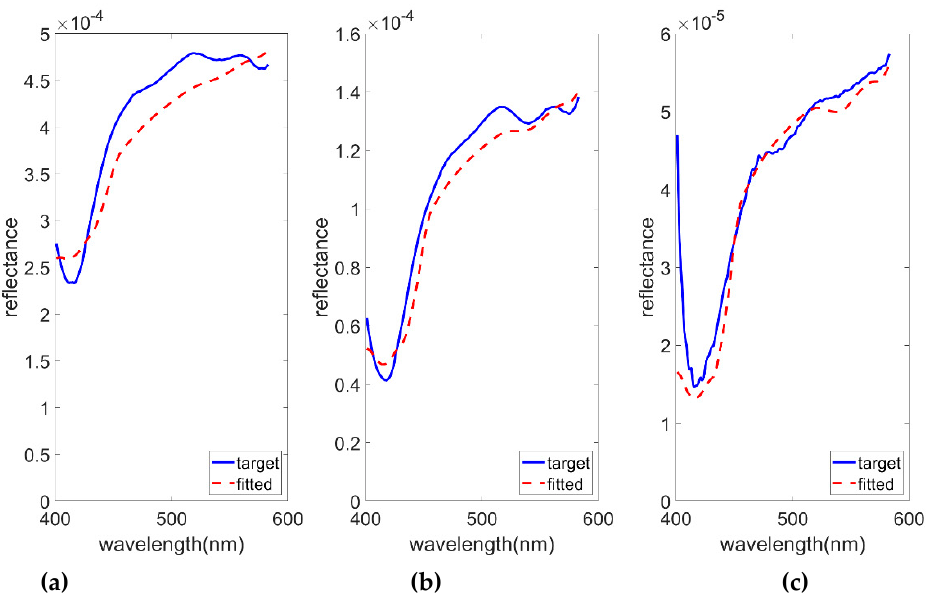
Figure 5. Example of fitted spectra and target in-vivo spectra measured from detection fibers located at SDS equal to ( a ) 0.22 mm, ( b ) 0.45 mm, and ( c ) 0.73 mm.